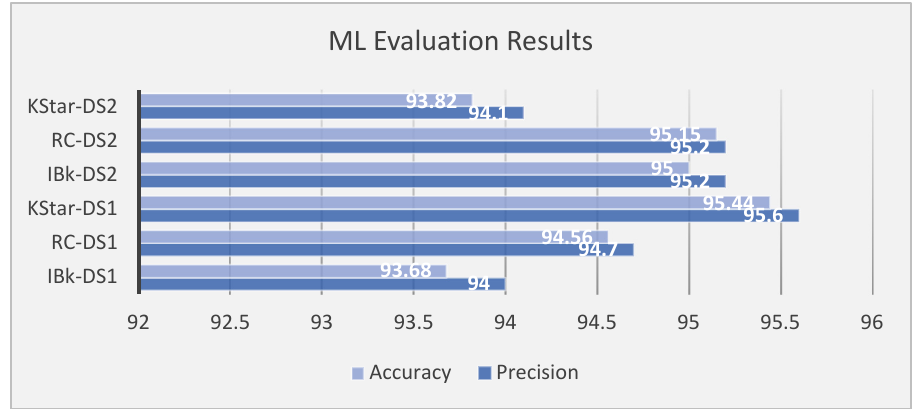
Figure 16. Weka Classifier Evaluation Results.